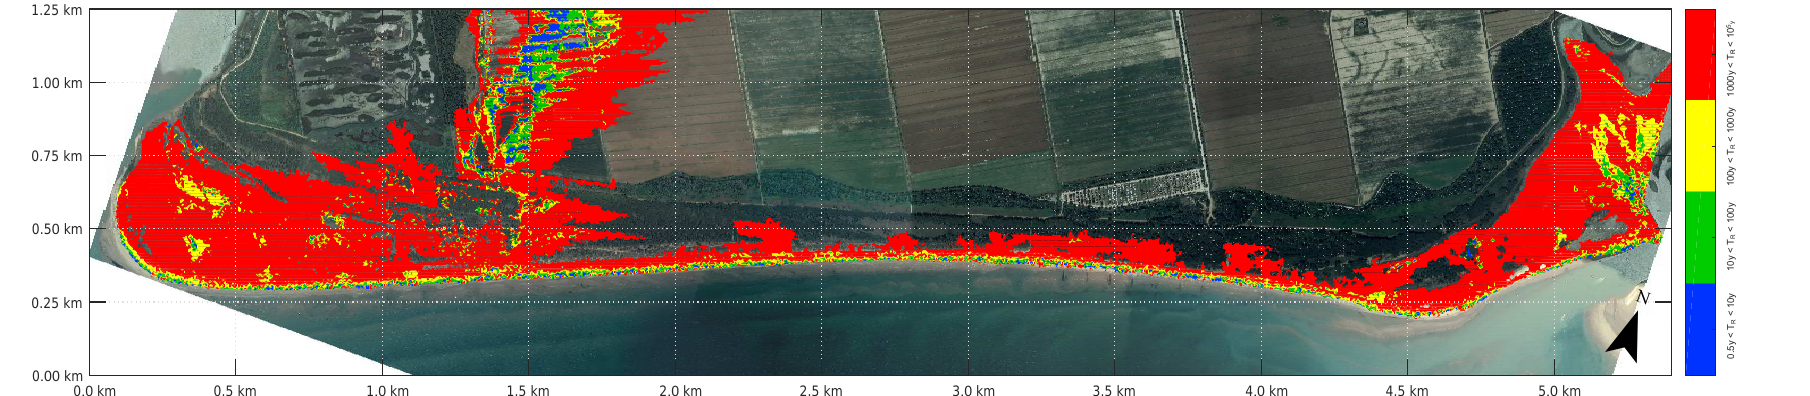
Figure 10. Hazard map (cell VE2): Probability that flooding level 0.5 m is exceeded, expressed as return period T R